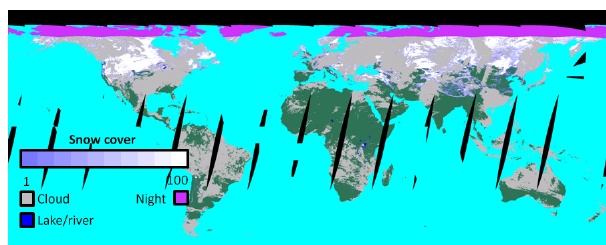
Figure 8. MODIS global snow cover on 14 January 2017. Global snow cover is from MOD10C1.A2017014.006. ∗ .hdf. Snow cover is shown with the cloud cover data layer overlaid; the snow cover and cloud cover are in separate data layers in the